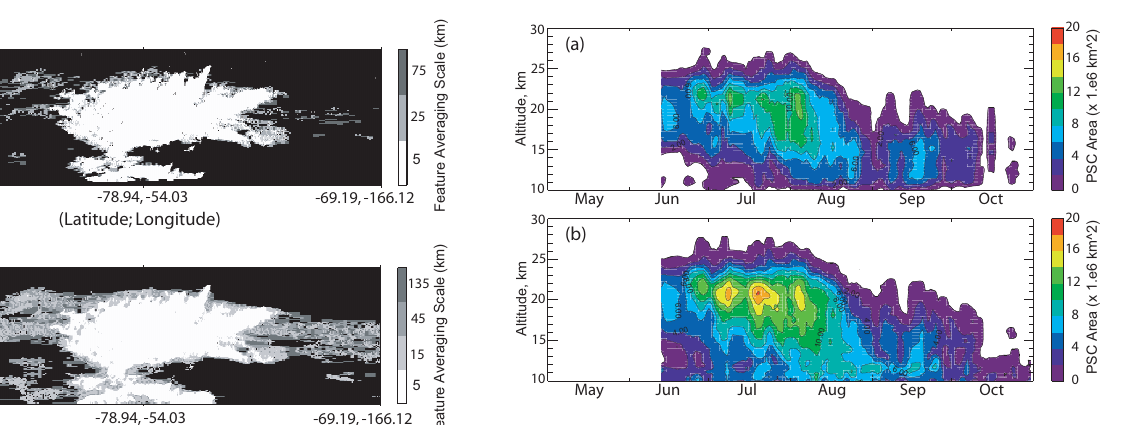
Fig. 3. Daily PSC areal coverage as a function of altitude for the 2006 Antarctic season calculated using the (a) v1 and (b) second- generation detection